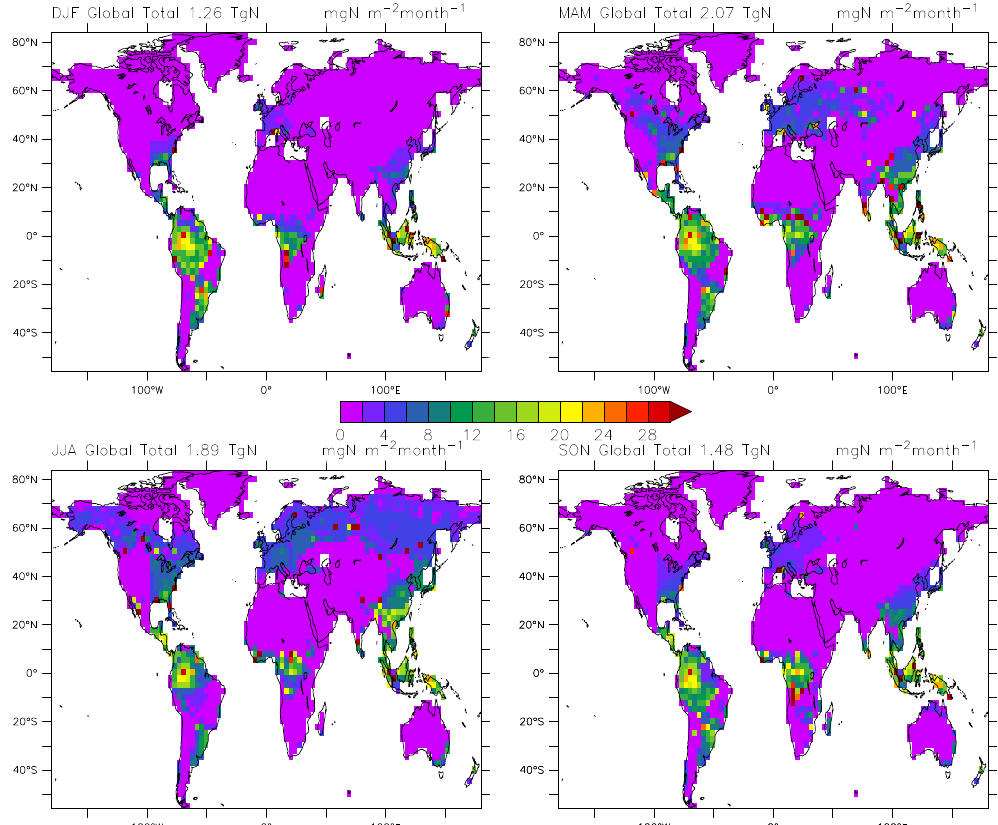
Figure 2. Global seasonal mean soil N 2 O emissions (with potential vegetation) averaged over the years 1970–2005. DJF (December, January and February), stands for Northern Hemisphere winter; MAM (March, April and May) for spring; JJA (June, July and August) for summer; and SON (September, October and November) for